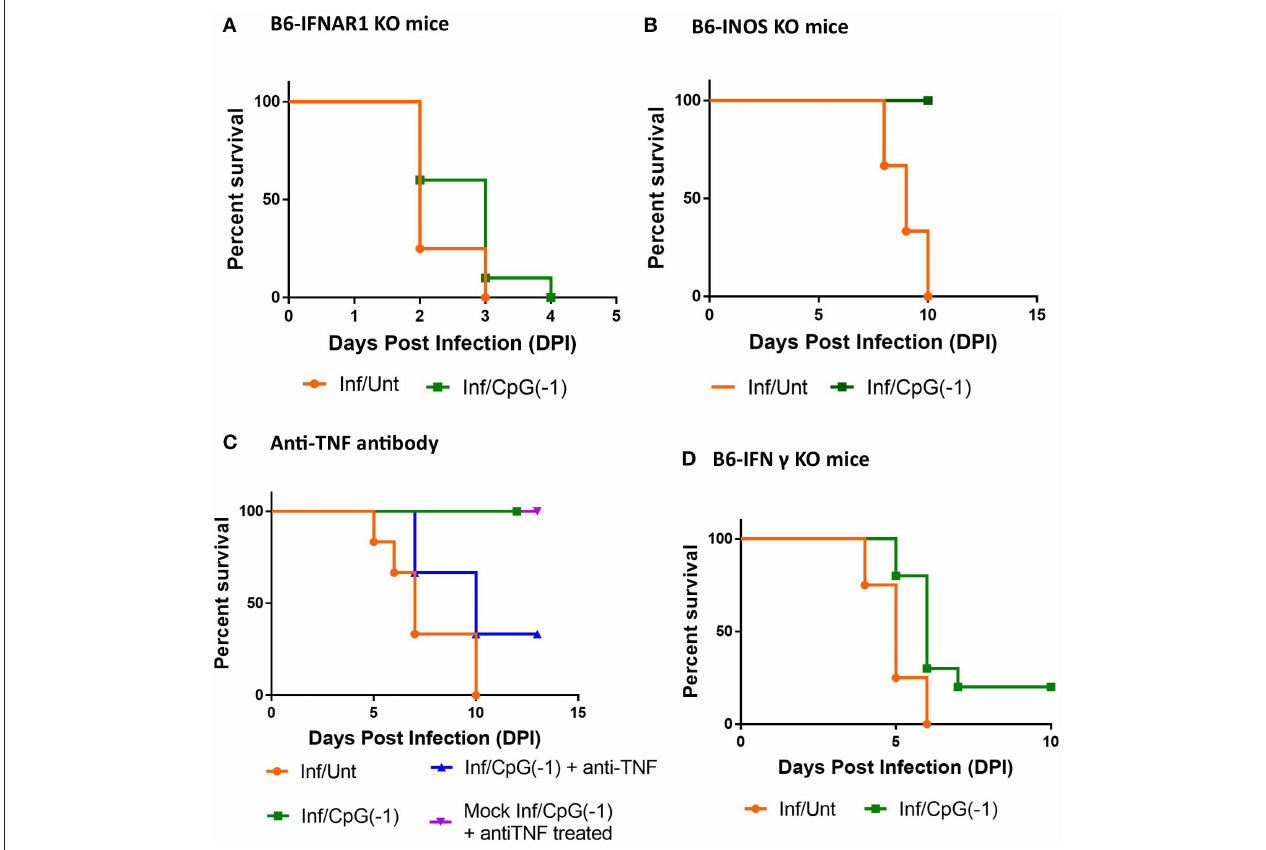
FIGURE 7 | CpG ODN treatment of SINV-infected B6-IFNAR1 KO, B6-iNOS KO, anti- TNF antibody treated, and B6-IFNy KO mice: Survival of (A) Type I interferon receptor knock out (B6-IFNAR1 KO) mice (B) B6-iNOS KO mice, and (D) Interferon gamma Knock out (B6-IFNgKO) mice (D) treated with CpG ODN (50 µ g IP on P2) and infected with SINV (25PFU SC on P3). (C) B6-WT mice were infected and treated as above received anti-TNF α antibodies (25 µ g IP 24h before infection and at 1, 3, and 5 dpi, blue). Control groups included mice infected and CpG ODN-treated as above that did not receive anti-TNF treatment (green), infected mice that received anti-TNF ab but no CpG ODN treatment (orange), as well as mock-infected mice that received CpG ODN and anti-TNF treatments (purple). The results are representation of two independent experiments ( n = 3/group each) with similar